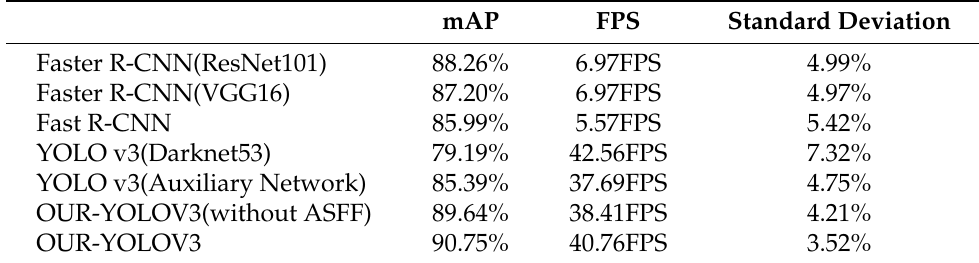
Table 3. Comparison of detection frame rates and standard deviations on the DOTA dataset (%).